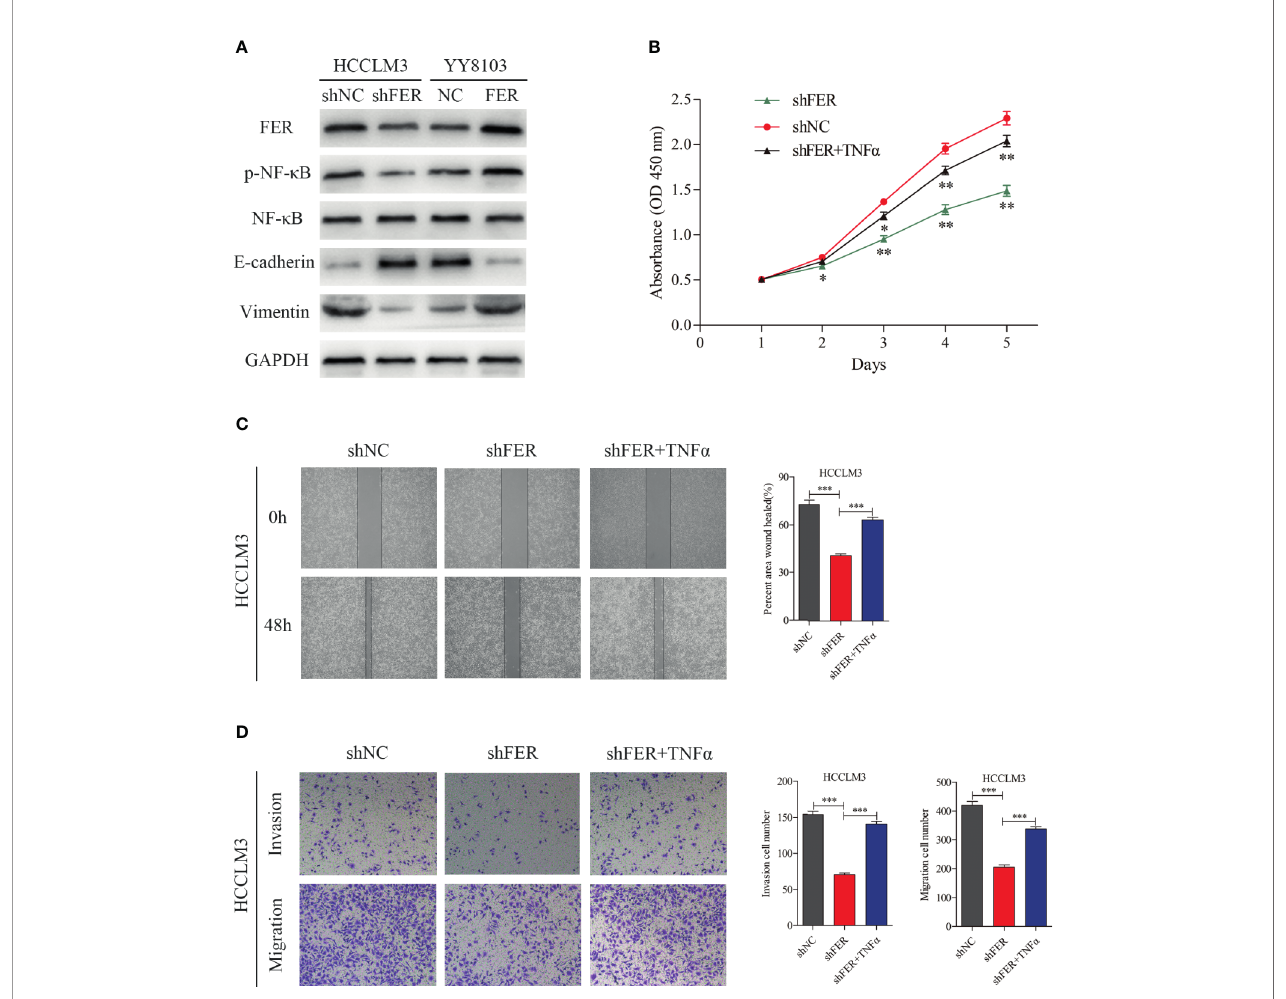
FIGURE 5 | FER facilitates HCC progression by activating NF- k B signaling and inducing EMT. (A) Proteins expression were measured by western blot in YY8103 and HCCLM3 cells. (B) CCK-8 assay was conducted to investigate the proliferation of HCCLM3-shFER cells treated with TNF a . (C) Wound healing assay was performed to evaluate the motility of HCCLM3-shFER cells treated with TNF a . (D) Cell invasion and migration in the indicated groups were detected by transwell assays. (*P < 0.05, **P < 0.01, ***P <